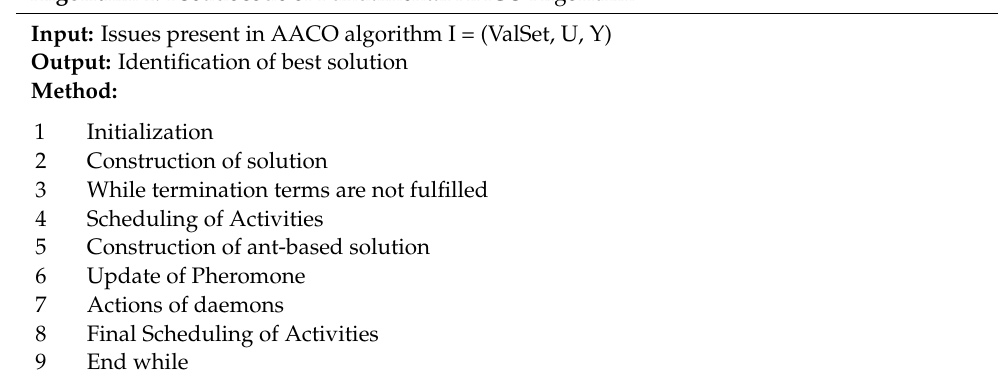
Algorithm 1: Pseudocode of Fundamental AACO